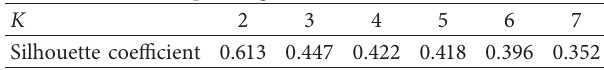
Table 2: Corresponding silhouette coefficient of each K